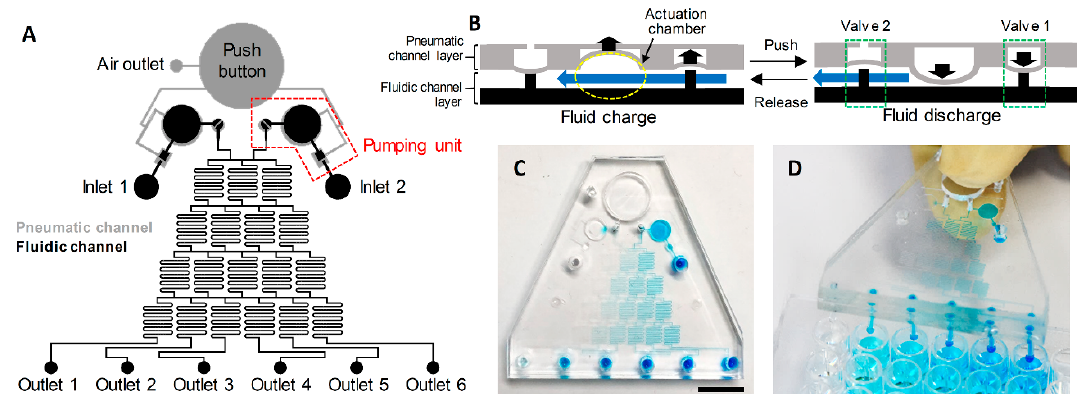
Figure 1. Design and working principle of the finger-actuated concentration gradient generator. ( A ) Drawing of the device design. ( B ) Operation principle of the pumping unit. The red dotted box in panel A indicates the single pumping unit. ( C ) Six concentrations with a linear gradient are generated from the device. Scale bar = 1 cm. ( D ) The picture of the device operation on the 96-well microplate.